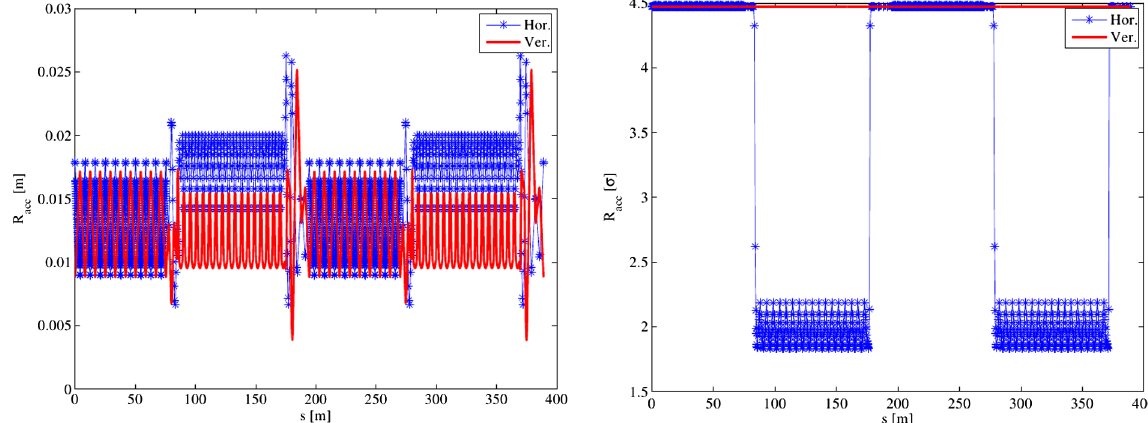
FIG. 15. The required acceptance around the PDR in order to fit the positron beam in units meters (left) and in units of beam sizes (right).